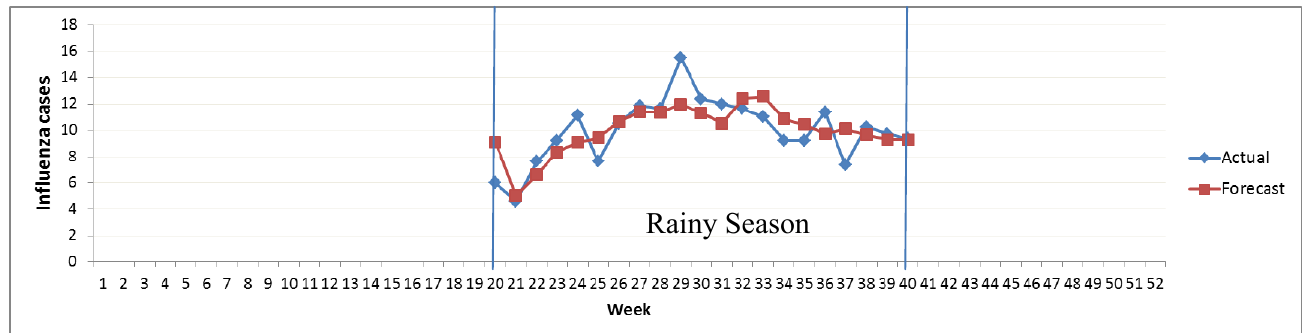
Figure 7. Relationship between actual and forecast influenza incidences